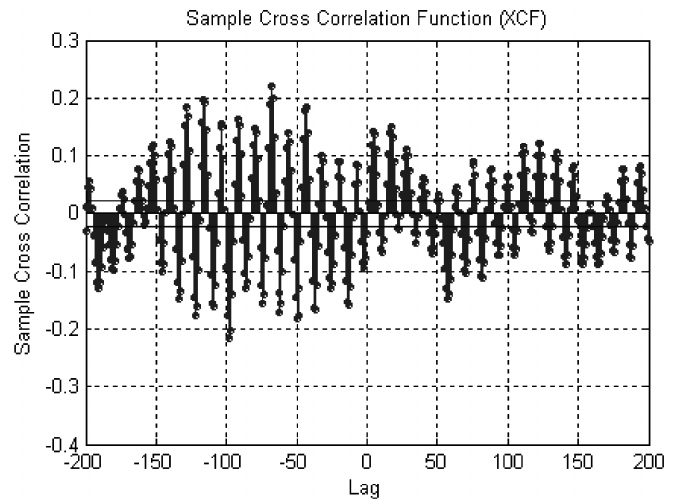
Fig. 6. The direct cross-correlation